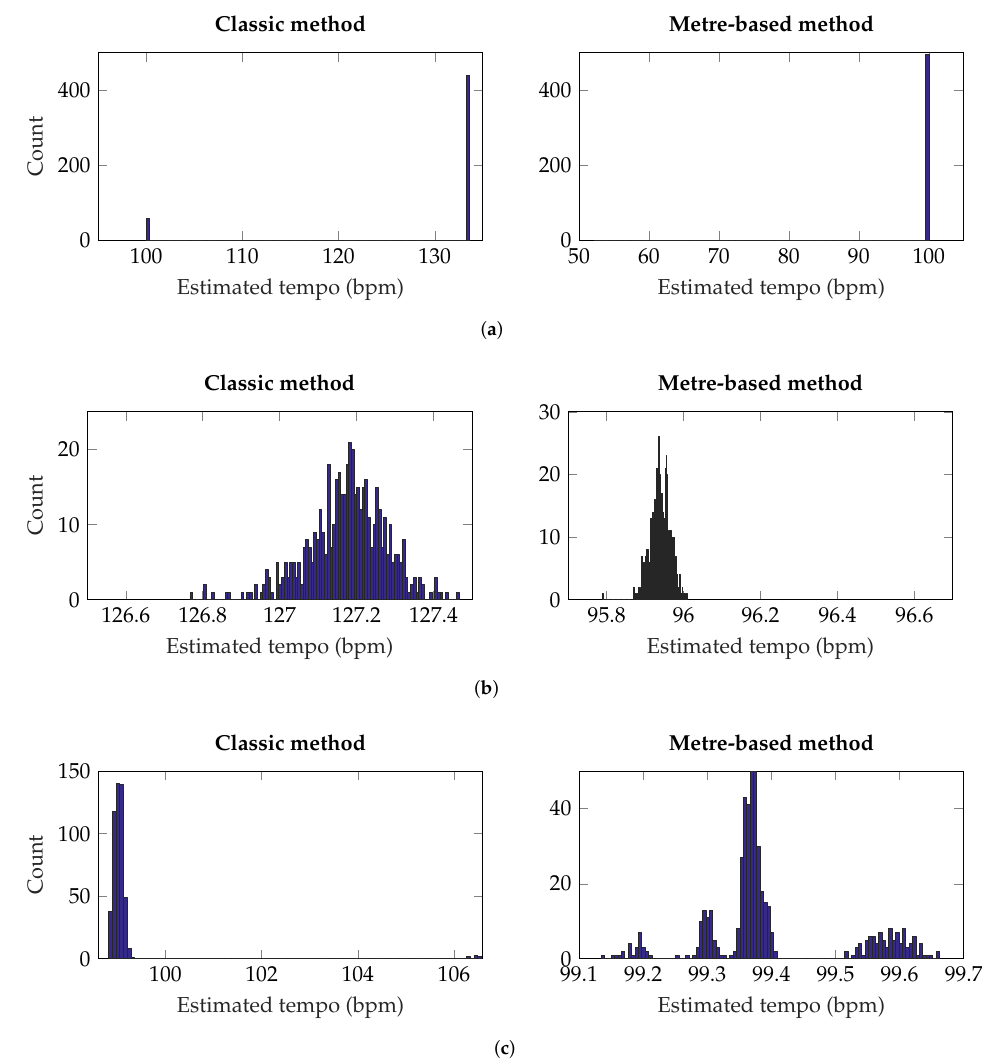
Figure 13. Estimated tempo for three songs, 500 mixes each using Equation (7). In each histogram, the data is split into 100 bins. Overall, performance is better for the metre-based method, as it demonstrates greater accuracy and improved robustness to changes in the mix. ( a ) “Burning Bridges”—The correct tempo is 100 bpm; ( b ) “I’m Alright”—The correct tempo is 96 bpm; ( c ) “What I Want”—The correct tempo is 99 bpm.